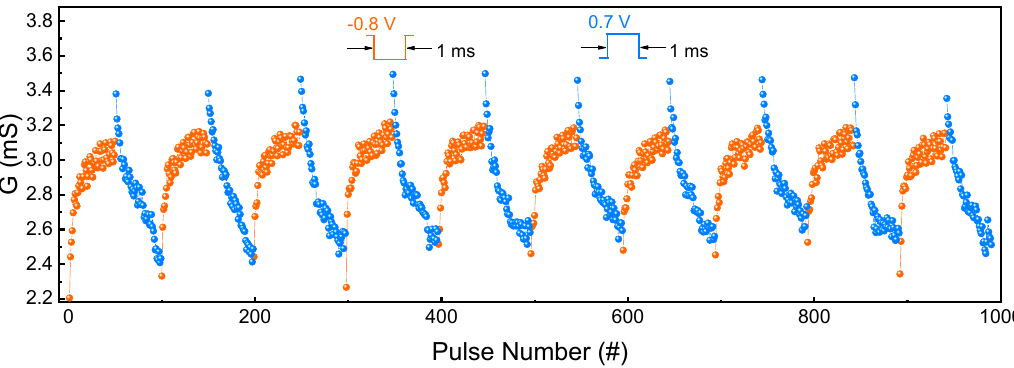
Figure 5. Potentiation and depression characteristics of the Pt/TiO 2 /HfAlO x /TiN RRAM device.